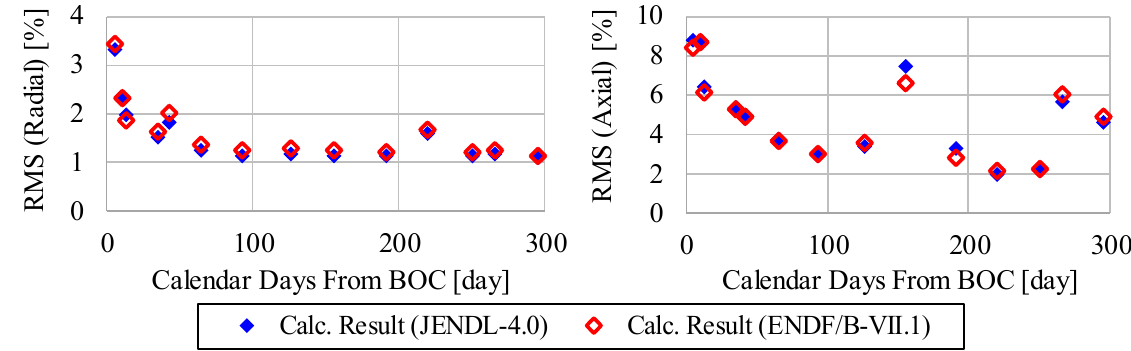
Figure 8. Detector Signal Results of Cycle 2 (Left: Radial, Right: